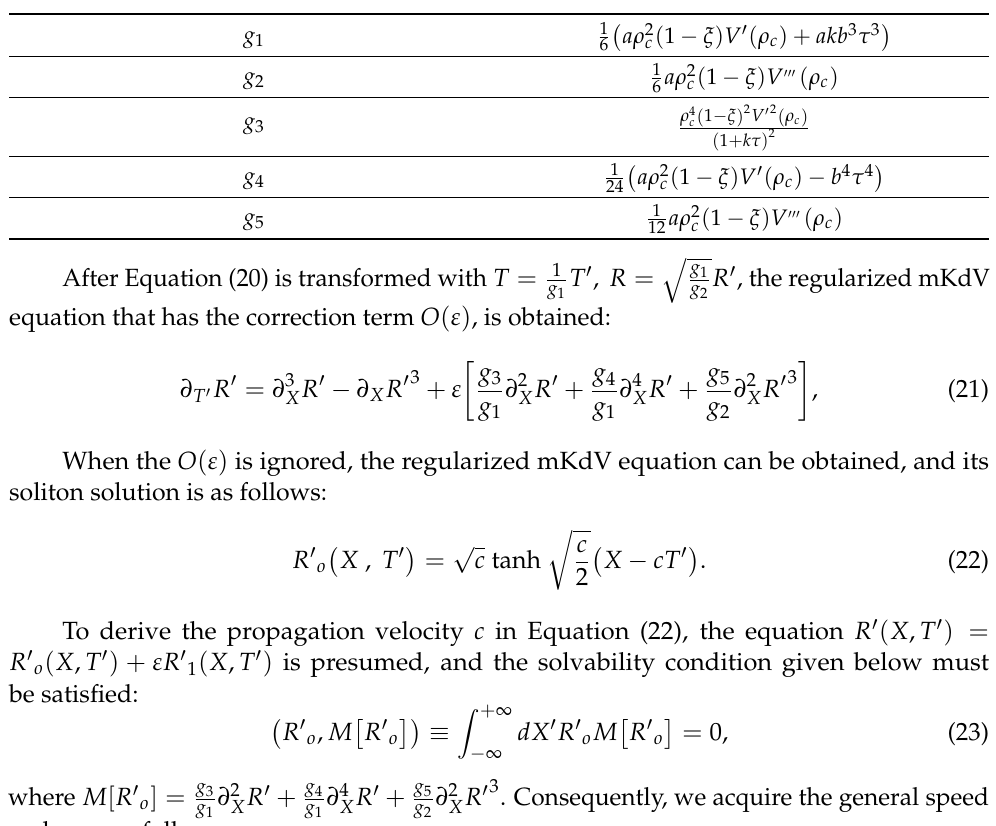
Table 2. The coefficients g i of the new model.